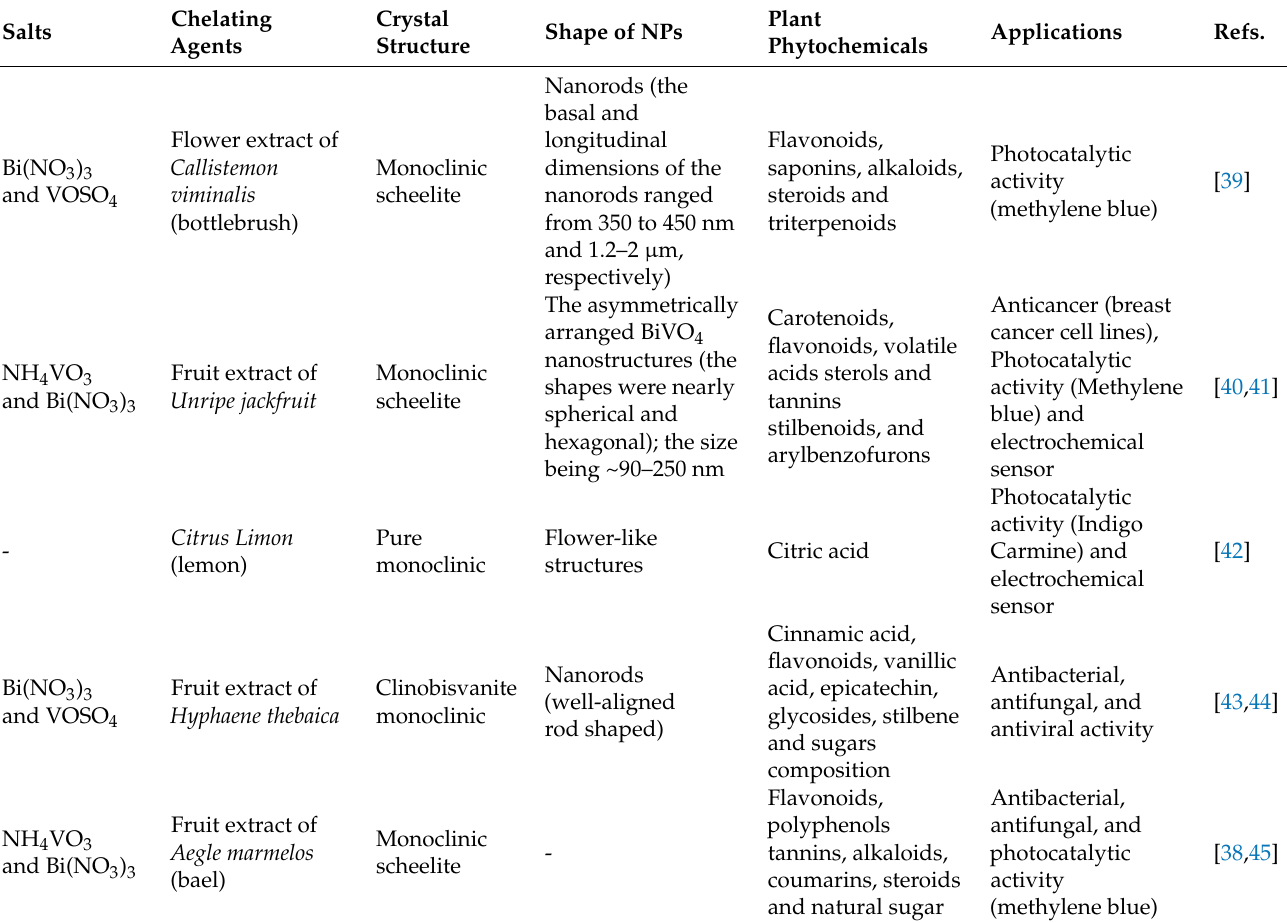
Table 1. Some selected examples of BiVO 4 NPs synthesized using eco-friendly